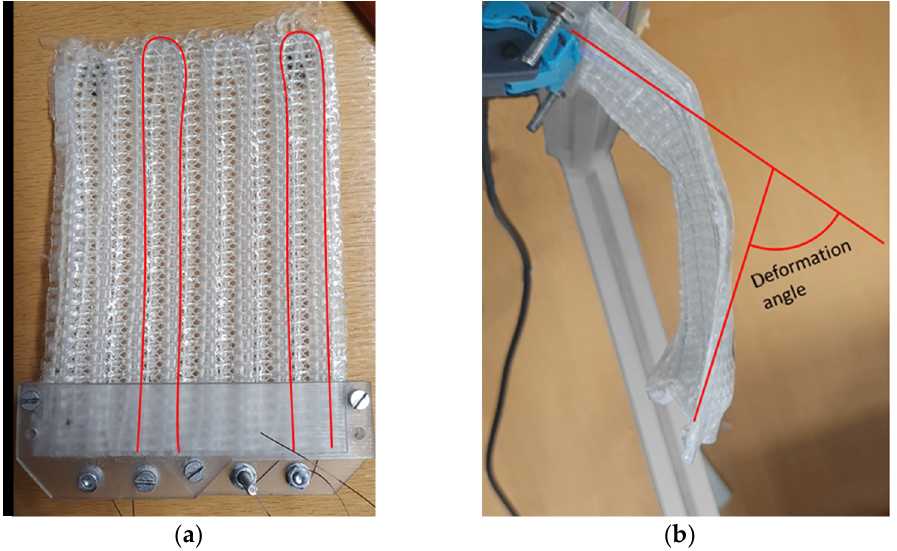
Figure 14. ( a ) IFRC specimen Var1 with two integrated SMA loops and ( b ) deformed IFRC specimen Var1 with two activated SMA loops and a geometric approximation of the deformation angle. The specimen with one loop showed the aforementioned local curling of the free end, which resulted in deformations close to no bending. Furthermore, a specimen with six loops showed a large deformation, up to 180 ◦ , which could not be captured with the laser triangulation setup. The resulting deformation angles after activation and deactivation are displayed in Figure 15.